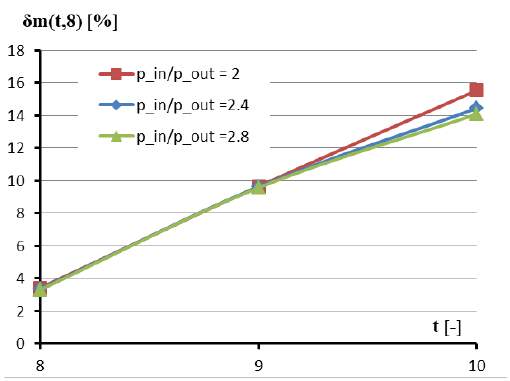
. m ( t ,8 ) [%] depending on